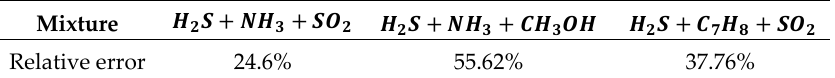
Table 2. Ternary mixture reconstruction